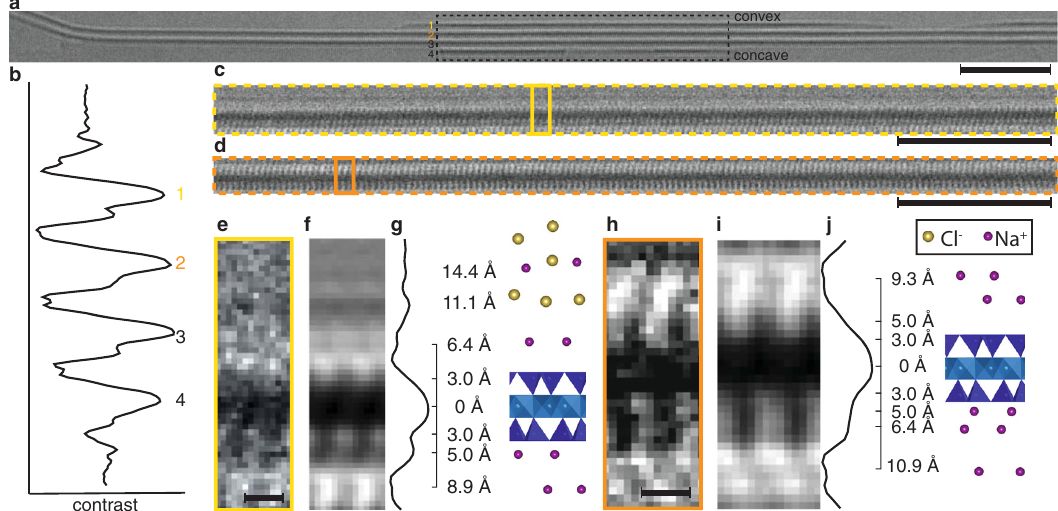
Fig. 2 CryoEM structure of Na-Mt and aqueous interfacial solution. a Na-Mt tactoid with four layers, each separated by 19 Å (scale bar represents 20 nm). b Contrast pro fi le integrated along box in ( a ). c Layer 1 enlarged. d Layer 2 enlarged. e Two unit cell wide region from layer 1 showing the interface with the aqueous solution (scale bar represents 5 Å). f Average unit cell, duplicated for comparison to ( e ). g Contrast pro fi le normal to layer 1, showing distances to local contrast minima relative to the layer midplane and proposed structural model of Mt and electrolyte structure adjacent. h Two unit cell wide region from layer 2. i Average unit cell, duplicated for clarity. j Contrast pro fi le normal to layer 2, with structural model of Mt and counterion structure